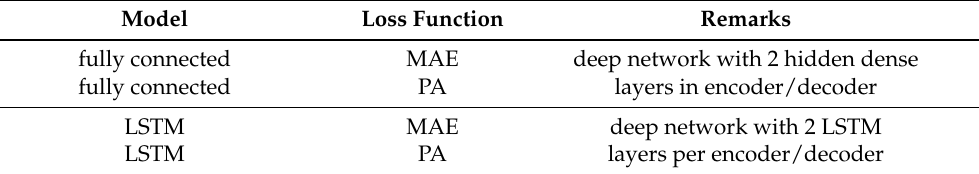
Table 1. Experiments to compare model types and loss functions. MAE stands for mean absolute error and PA for principal angle